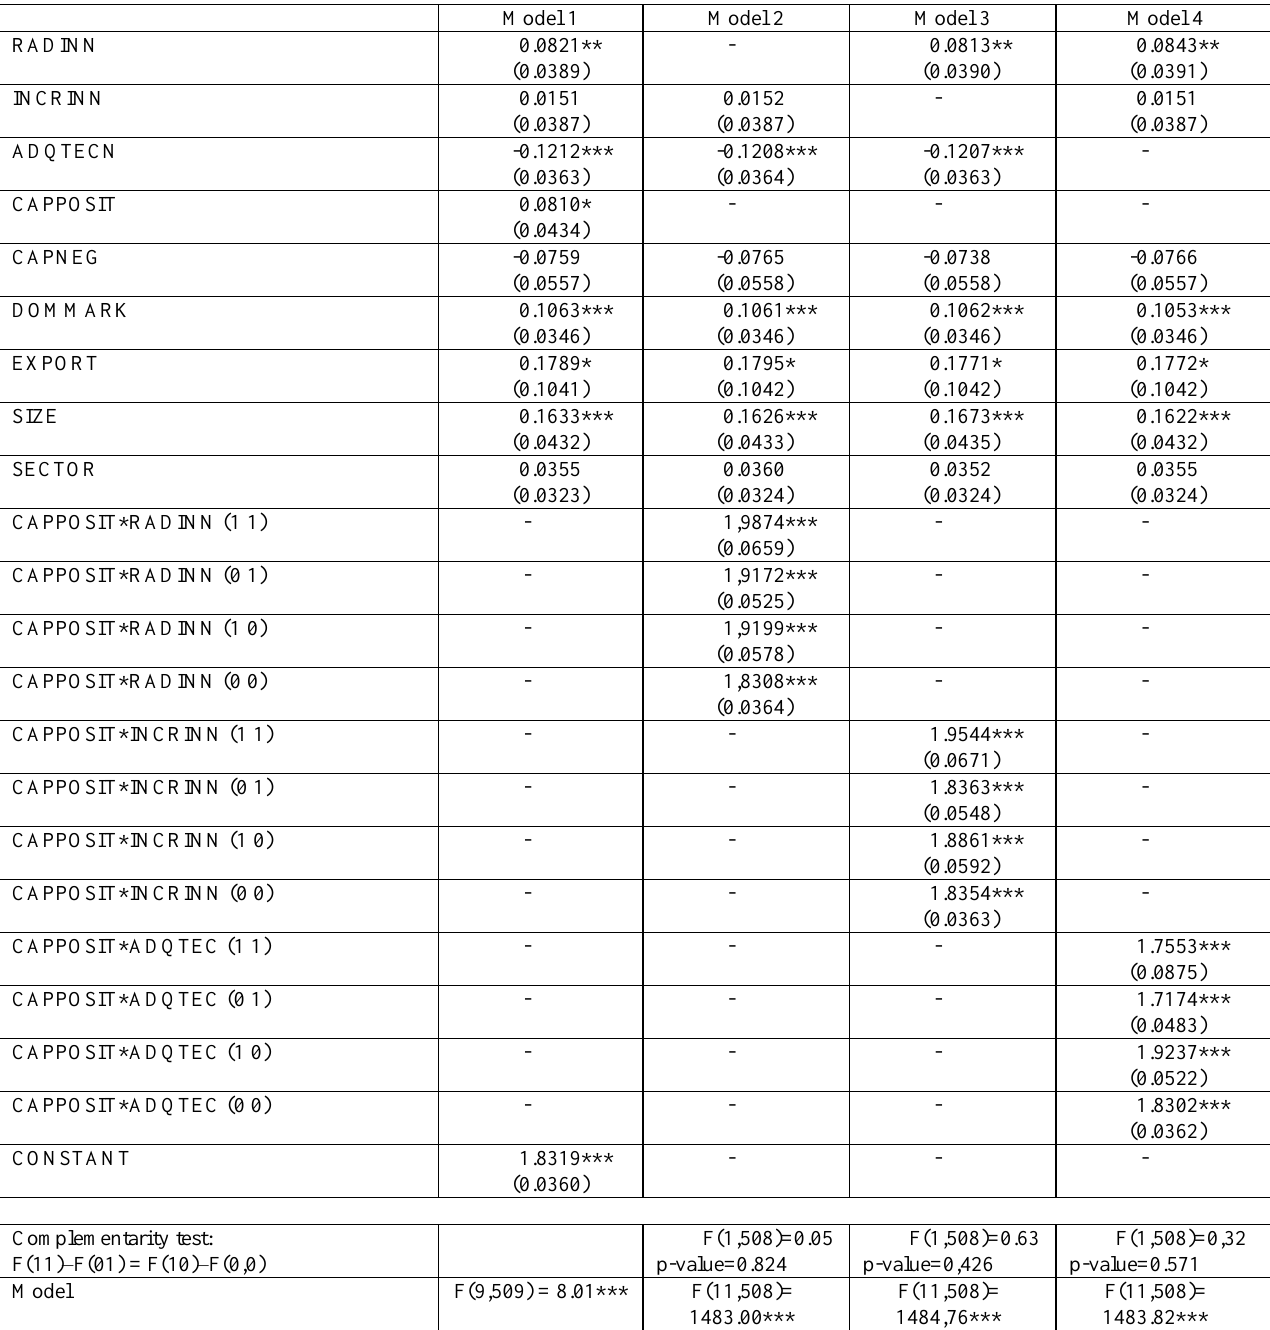
Table 2: Outputs of the